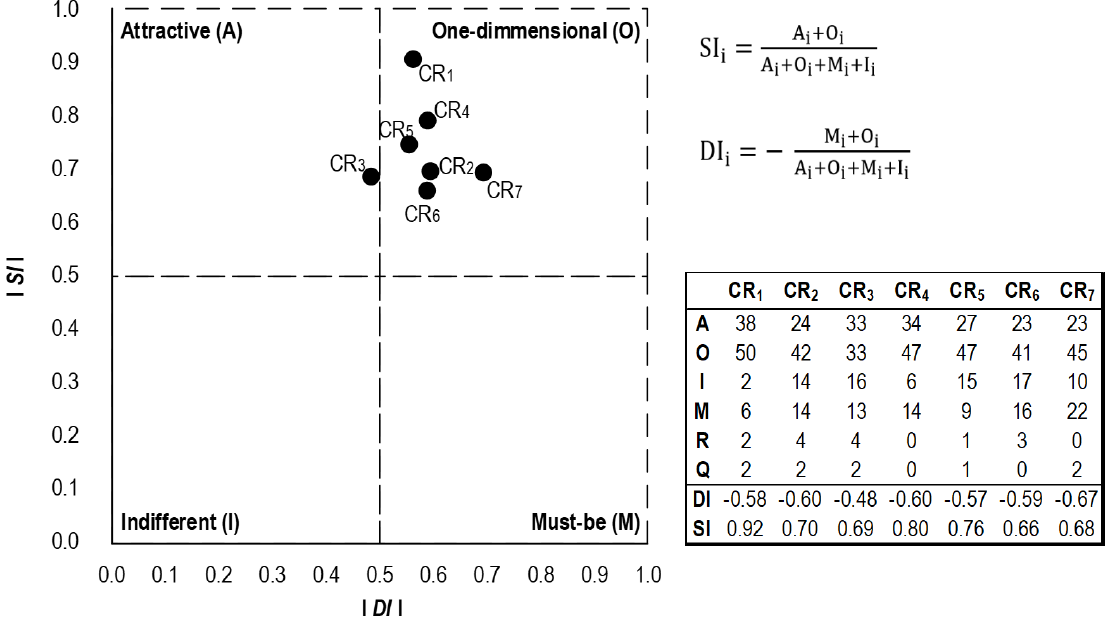
Figure 3. Overall results of requirements categorization based on Kano model.